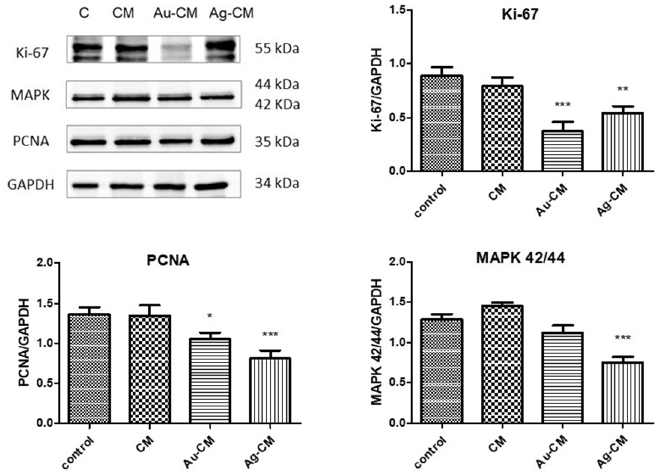
Figure 10. Ki-67, PCNA and MAPK 42/44 expression in DLD-1 cells evaluated by Western blot. DLD-1 cells were treated with 40 µg/mL CM extract, 40 µg/mL Au-CM, and 4 µg/mL Ag-CM. In the upper panel are the images of the Western blot bands; in the lower panel are the results normalized to GAPDH. Statistical analysis was performed with one-way ANOVA and Bonferroni’s posttest (* p < 0.05, ** p < 0.01, *** p < 0.001 compared to control cells).